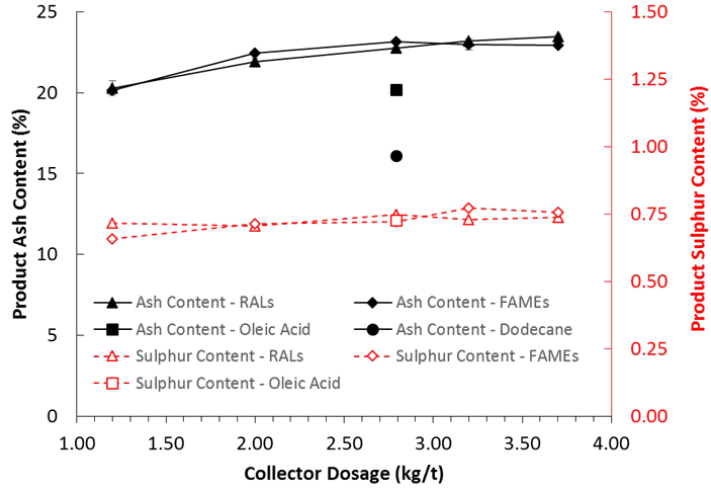
Figure 10. Site 2 flotation experiment product ash and sulphur content using RALs and FAMEs compared to oleic acid and dodecane controls at a fixed dosage of 2.79 kg /